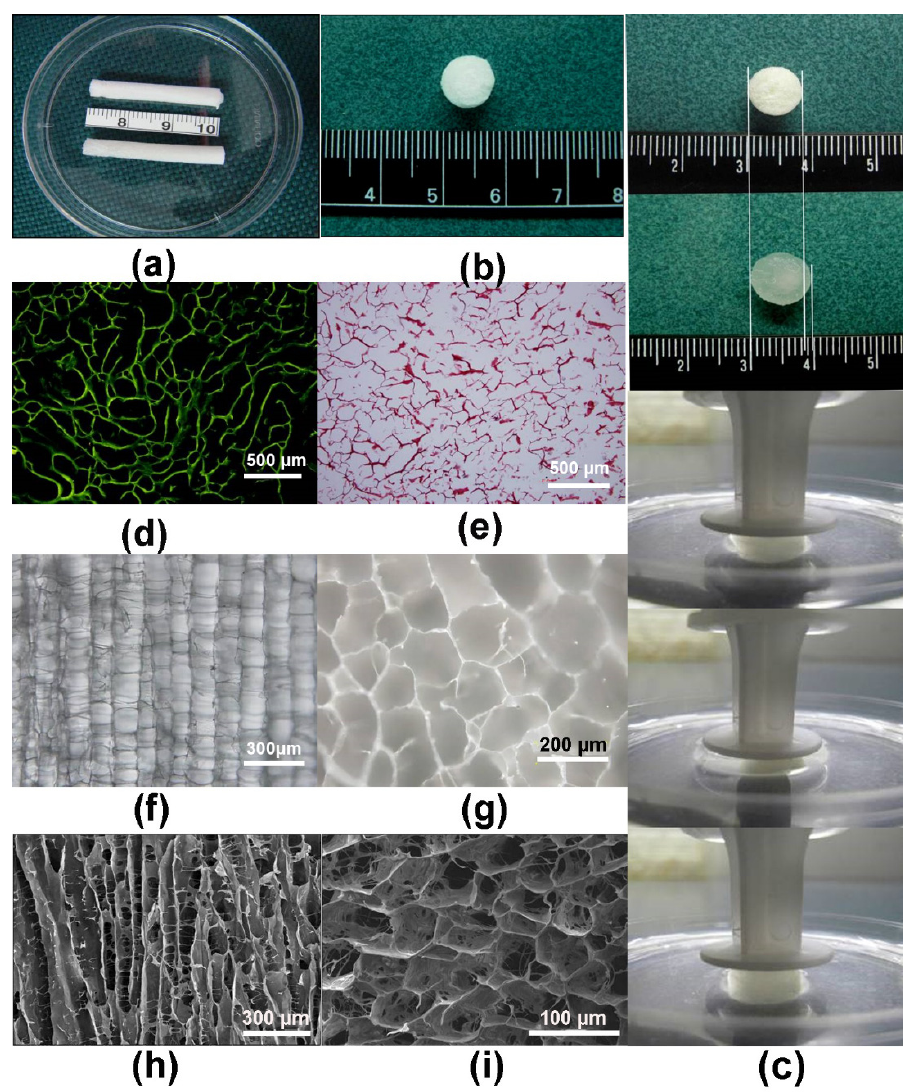
Figure 2. ( a ) General observation of scaffold. ( b ) Dry scaffold. ( c ) Comparison between dry and wet state scaffold. ( d ) Scaffold cross-section using collagen type II immunohistochemistry (light microscopy, × 100 magnification). ( e ) Safranin O staining of scaffold cross-section (light mi- croscopy, × 100 magnification). ( f ) Longitudinal section of scaffold (light microscopy, × 100 mag- nification). ( g ) Scaffold cross-section (light microscopy, × 100 magnification). ( h ) Scaffold longitu- dinal section (light microscopy, × 130 magnification). ( i ) Scaffold cross-section (light microscopy, × 130